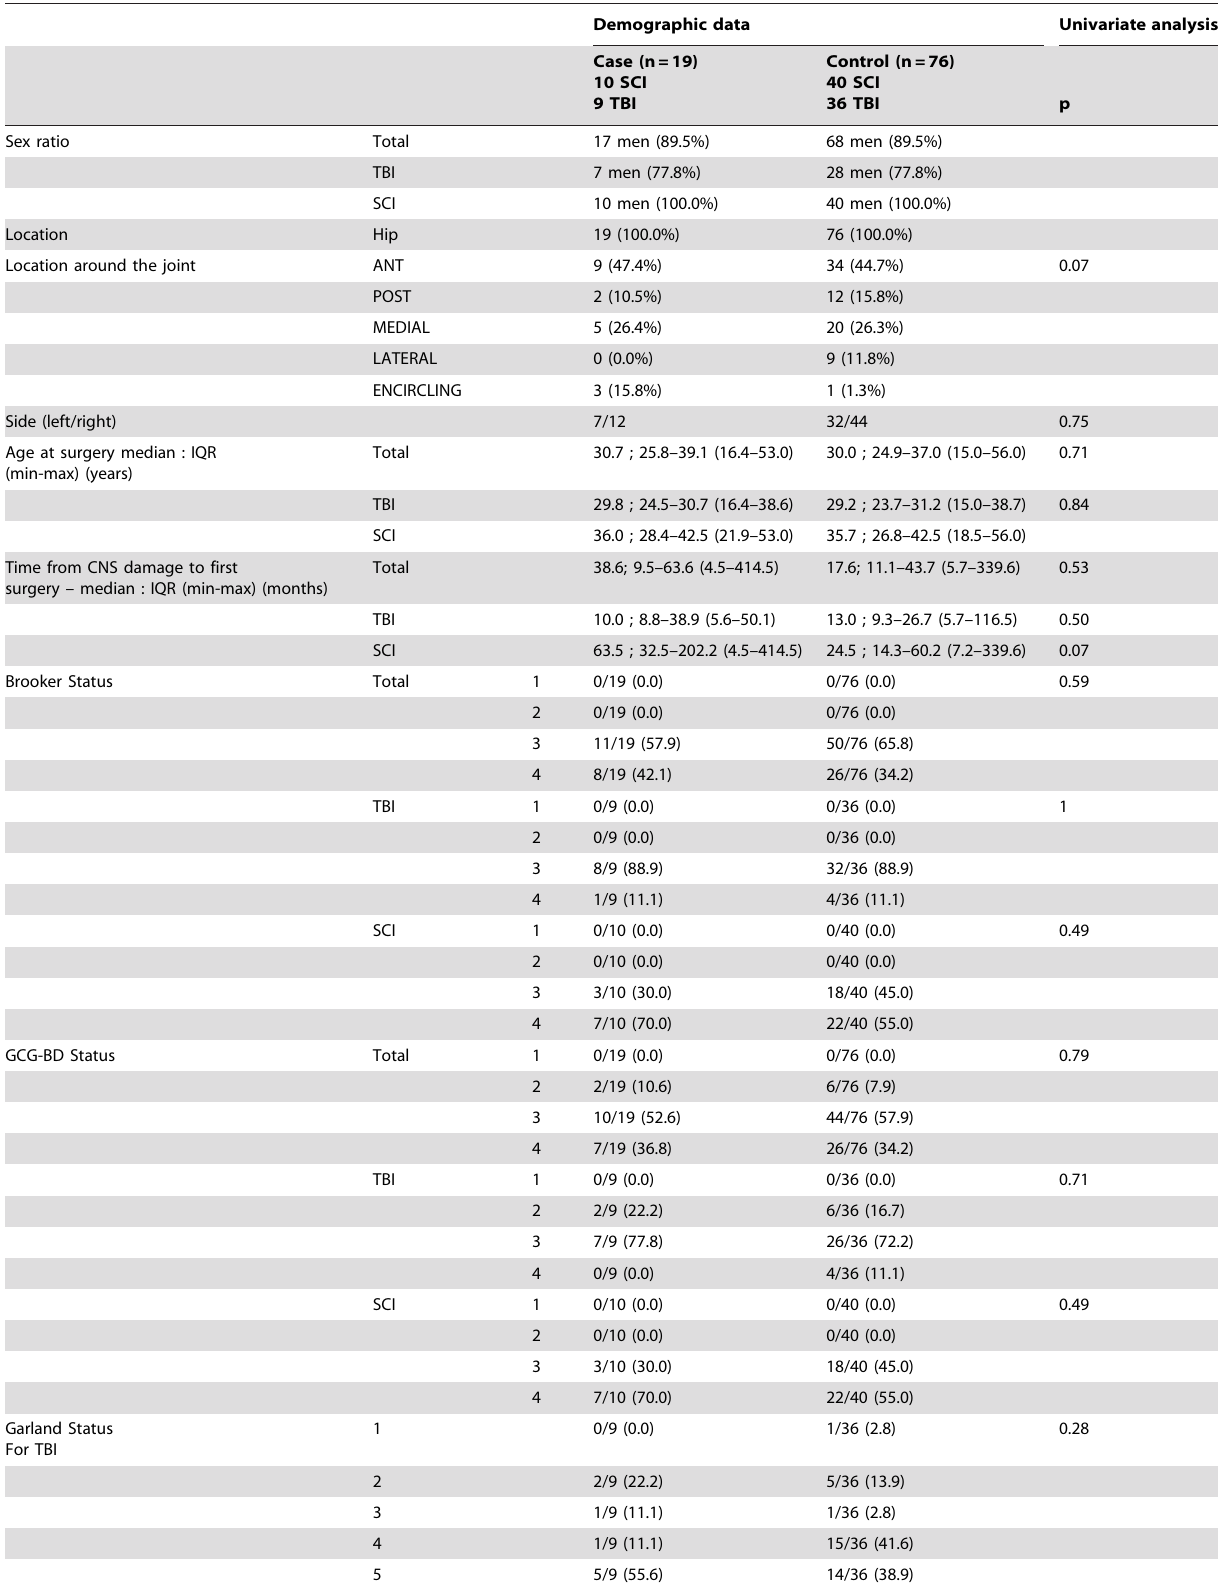
Table 1. Demographic data and univariate